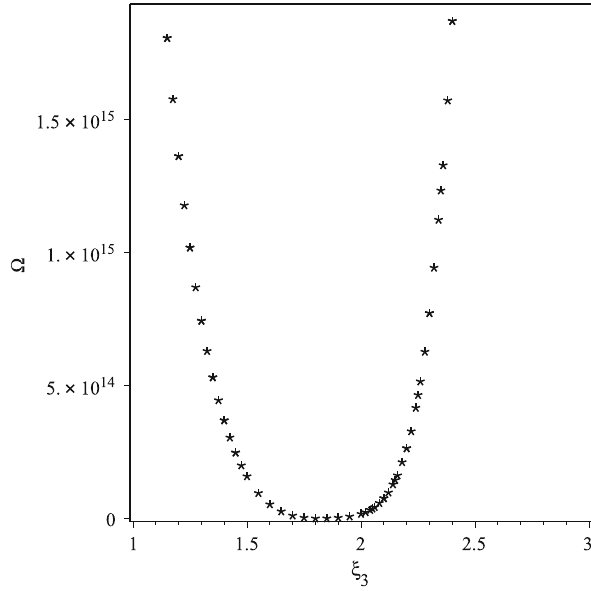
Fig. 8 Auxiliary function (cid:5) vs. the minimization parameter ξ 3 for ξ ∗ = 9 . 96 ,ξ ∗ = 1 . 85 and f ( R ) -parameters a = − 2 , b = 1 , c = 1 2 − 0 . 02. The minimum of (cid:5) corresponds to ξ ∗ = 1 . 85 ) = 5 . 3 × 10 11 9 . 96 ,ξ ∗ 3